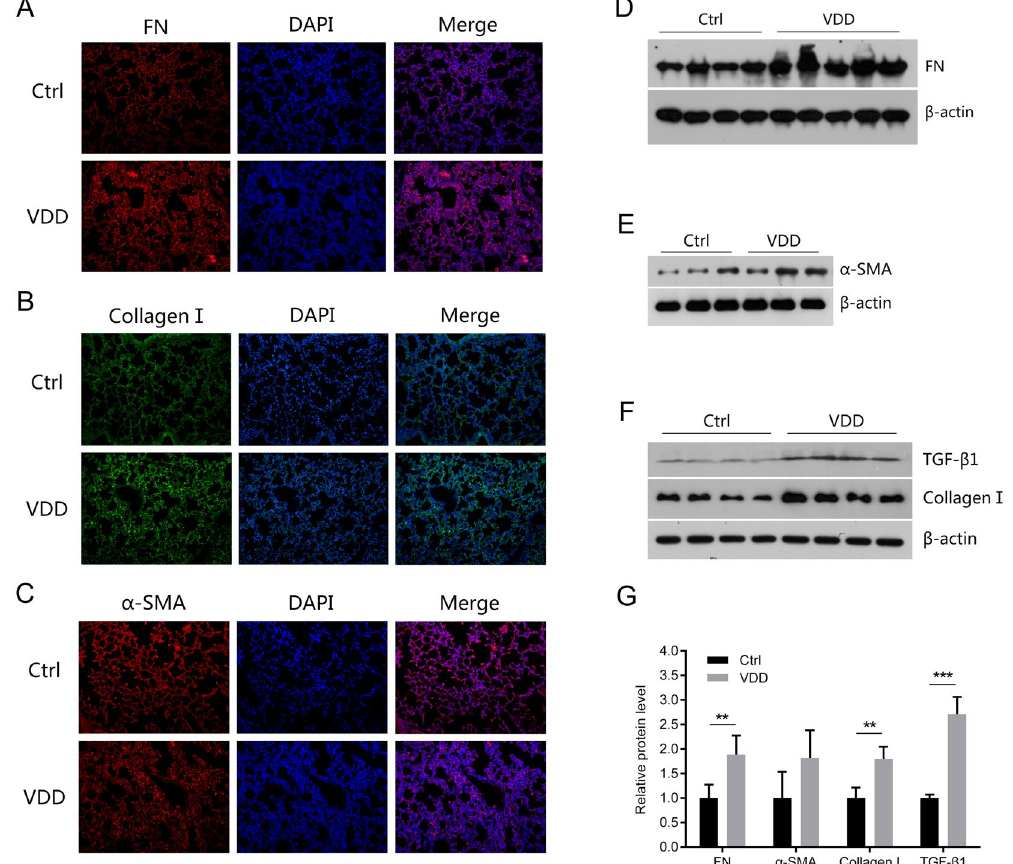
Figure 2. Chronic vitamin D deficiency promotes ECM deposition in the lung. ( A , B , C ) Immunofluorescence staining of the lung tissue with fibronectin, collagen I and α -SMA after two months of vitamin D deficiency. Original magnification: 200 × . ( D , E , F ) Western blotting of fibronectin, α -SMA, collagen I and TGF- β 1. ( G ) Relative expression of the proteins above. ** P < 0.01, *** P < 0.001 Ctrl versus VDD group (n = 5–6 in each group). FN: fibronectin; α -SMA: α -smooth muscle actin; TGF- β 1: transforming growth factor- β 1; Ctrl: control; VDD: chronic vitamin D deficiency. Statistics: Independent-sample two-tailed t -test. All electrophoresis was performed under the same conditions, and the gel images were cropped for concise presentation. The uncut images are provided in the Supplementary